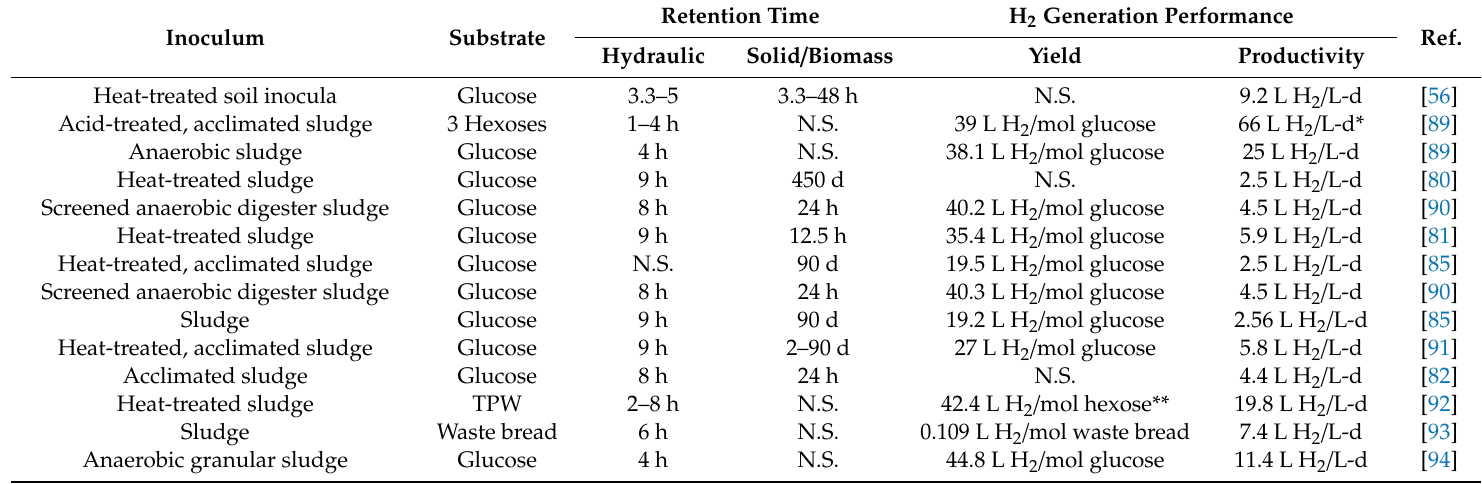
Table 3. Bioydrogen production e ffi ciency of di ff erent